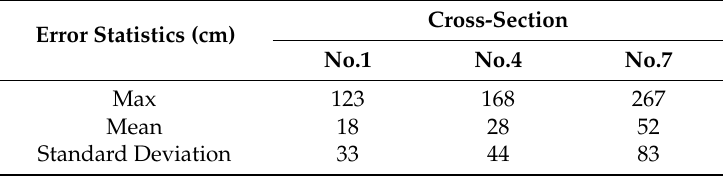
Table 1. Error statistics for validation tests.